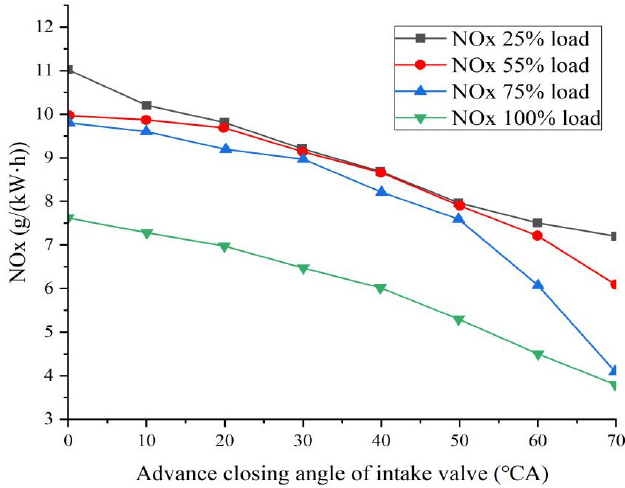
Figure 8. The impacts on NO x emission when Miller degree >